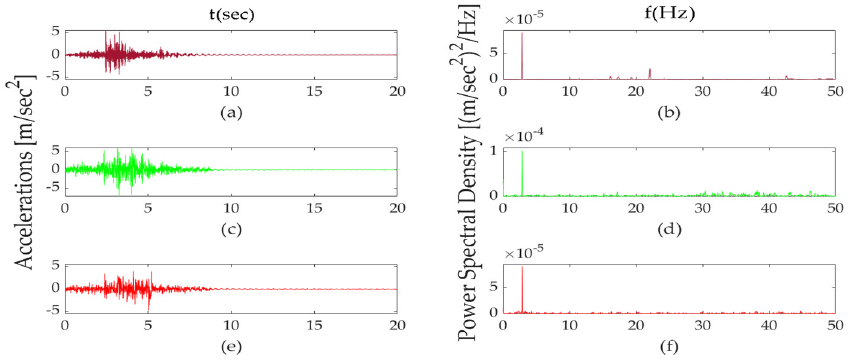
Figure 28. Comparison of the acceleration time histories and Power Spectral Density for Veh6 case: ( a , b ) numerical results at the middle of the bridge; ( c , d ) sensor 2; ( e , f ) sensor 5.